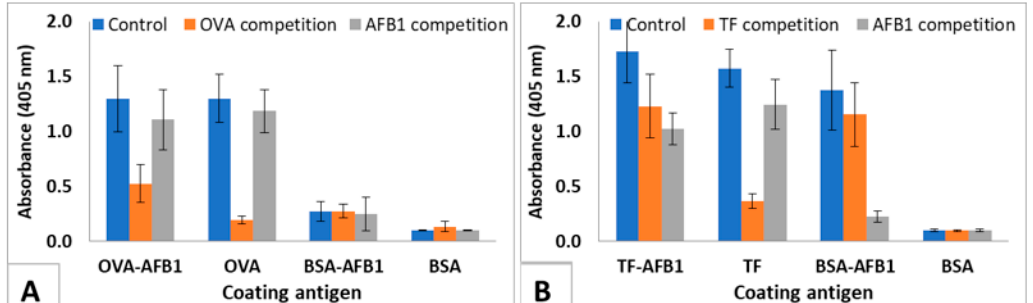
Figure 4. IC-ELISA showing interaction of mice sera with AFB1 and proteins. ( A ) OVA-AFB1-immunized mice sera with AFB1 (200 ng/µL serum) and OVA (1 µg/µL serum). ( B ) TF-AFB1-immunized mice sera with AFB1 (200 ng/µL serum) and TF (1 µg/µL serum). Serum dilutions are 1/5000. The results are presented as mean of 3 replicates. Error bars represent standard errors.